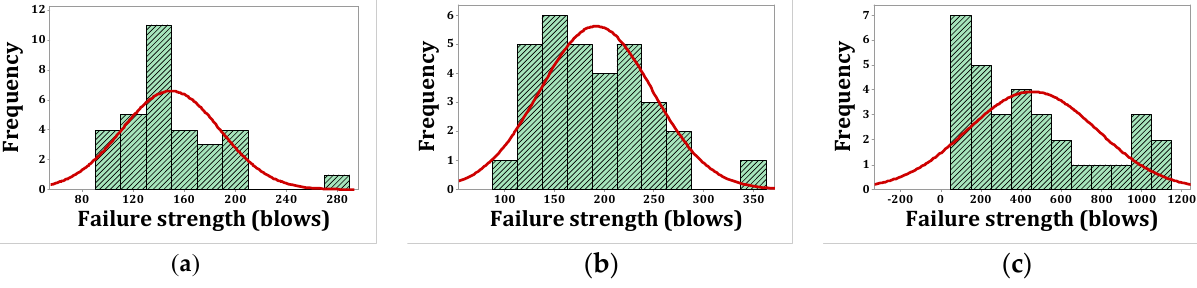
Figure 20. Distribution plots for failure strength (humid): ( a ) R, ( b ) F2, ( c ) F3.